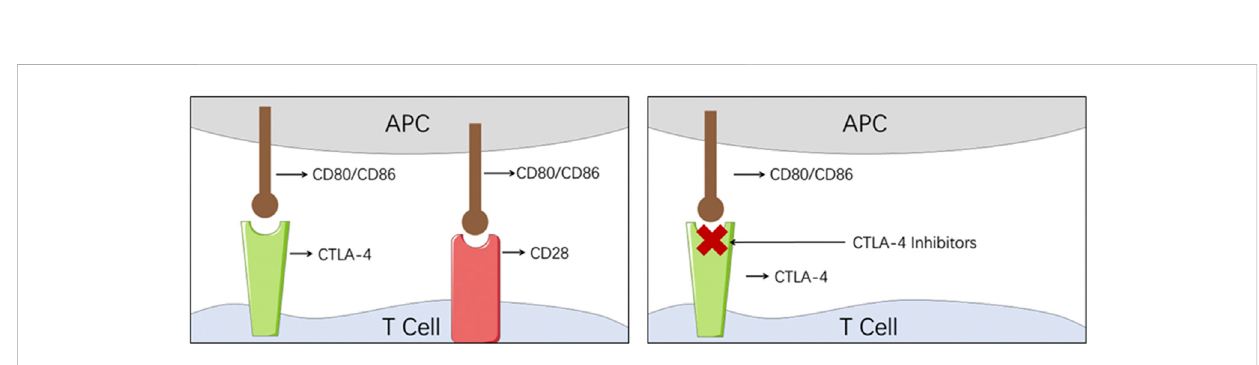
FIGURE 3 Illustration of the mechanism of CTLA-4 inhibitors. (APC, antigen-presenting cell; CTLA-4, cytotoxic T-lymphocyte-associated protein